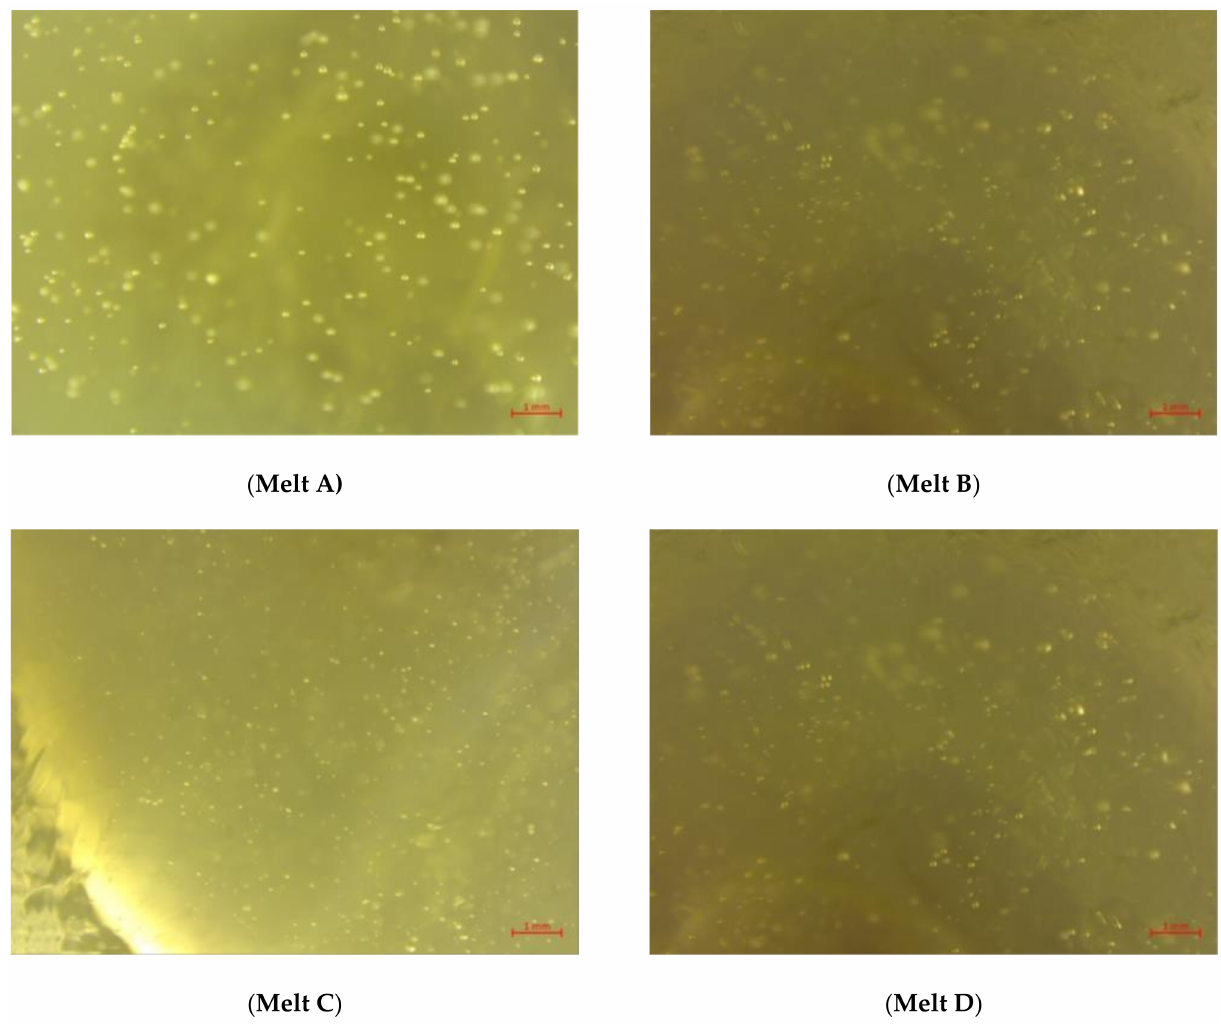
Figure 5. Microscopic images of the melts ( A – D